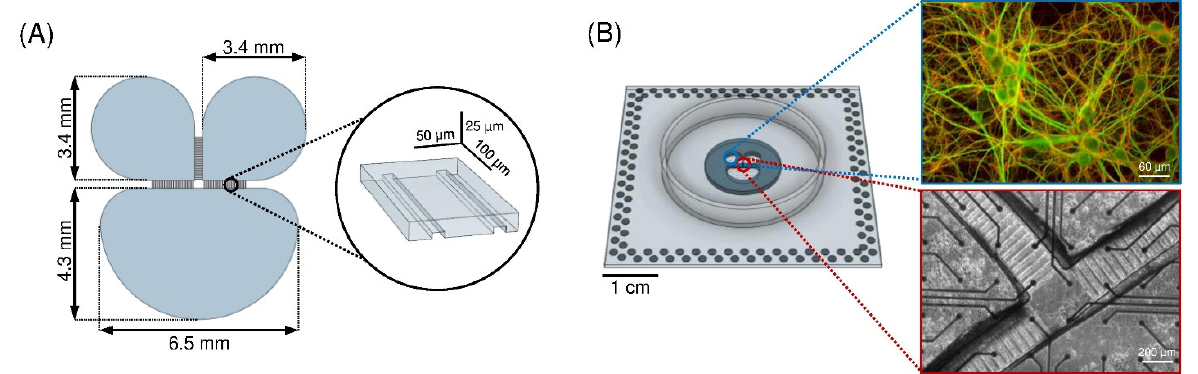
Figure 1. ( A ) Sketch of the silicon master (negative mold of the PDMS mask) used to create the polymeric device. In the inset, the dimensions of the microchannels of the PDMS mask are reported. ( B ) PDMS mask reversibly bonded to the MEA surface. ( Right , top ) Close-up of the cortical network (DIV 18) inside the compartment where microtubule-associated protein 2 (MAP2, green) and the vesicular glutamate transporter (Vglut1, red) are labeled. ( Right , bottom ) Close-up of the channel region of a cortical network organized in three interconnected sub-populations at DIV 18.